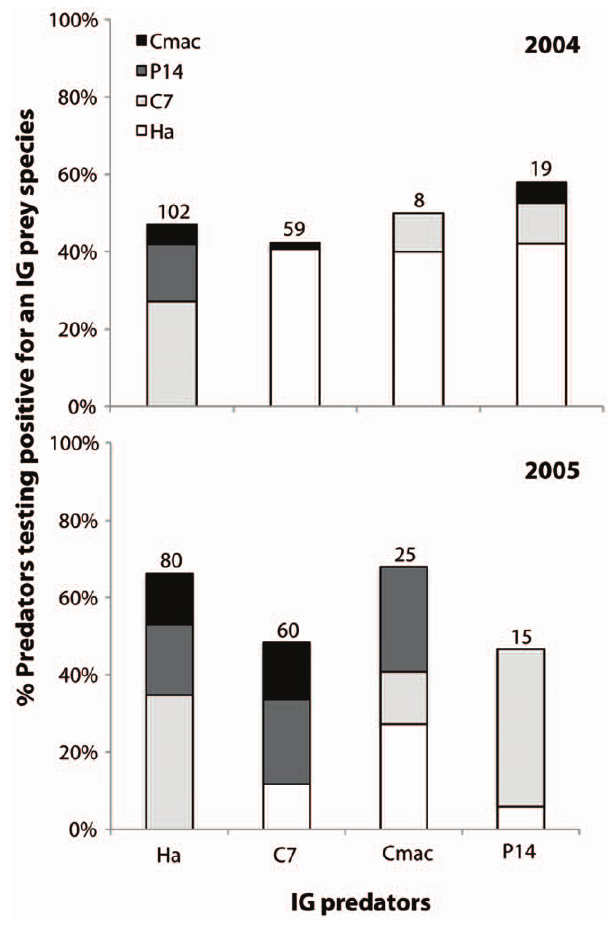
Figure 1. Levels of intraguild predation among four species of coccinellids measured by molecular gut content analysis in soybean fields in Que´bec, Canada, in 2004 and 2005. Results are expressed as the proportion of each species of intraguild prey detected in the gut of intraguild predators. Ha = Harmonia axyridis , C7 = Coccinella septempunctata , Cmac = Coleomegilla maculata , P14 = Propylea quatuordecimpunctata . Numbers above histogram bars repre- sent the number of individuals tested.